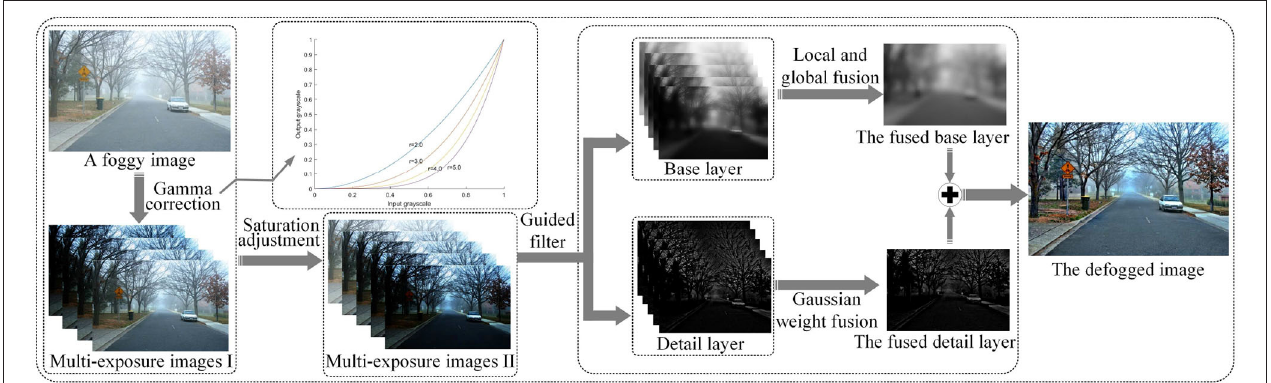
FIGURE 2 | The proposed image defogging framework based on image patch and multi-exposure